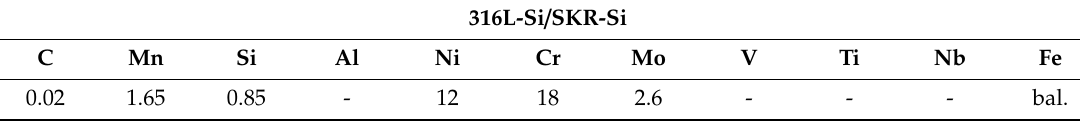
Table 3. Chemical composition of austenitic filler wire (wt %)